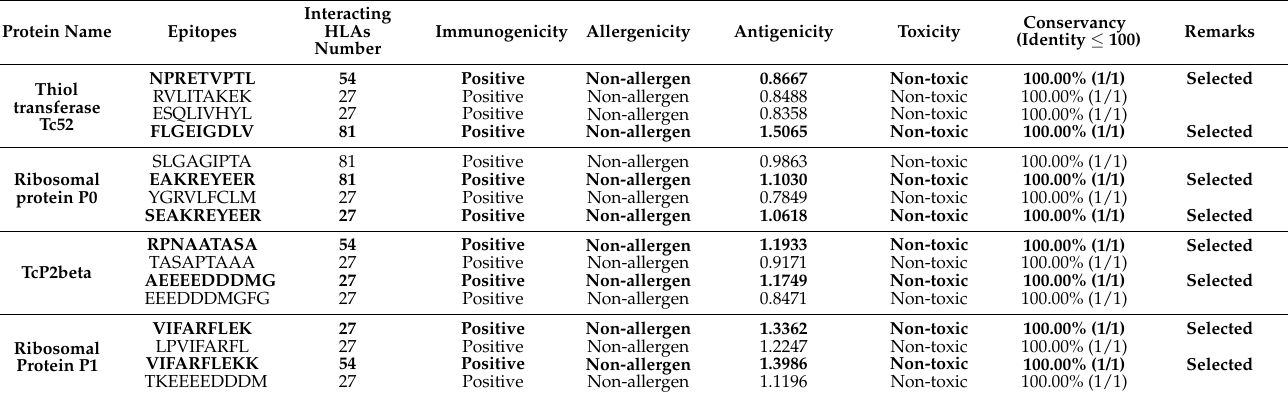
Table 2. Final CTL epitopes.